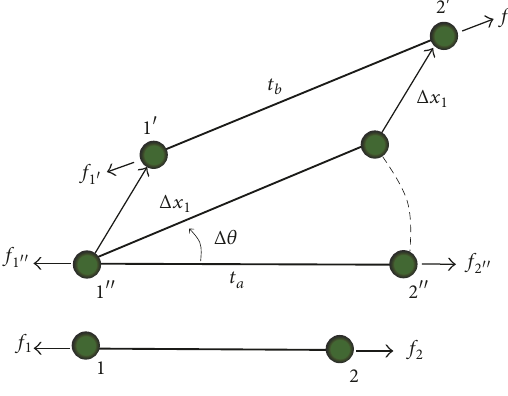
Figure 4: Particle internal